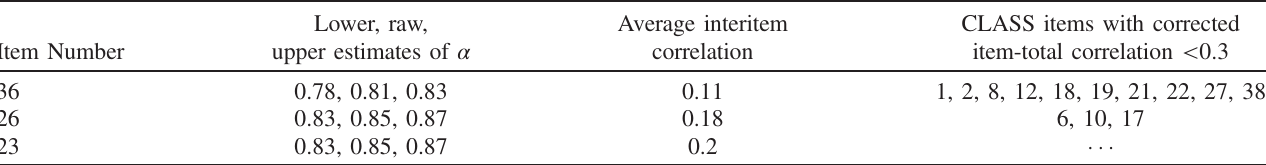
TABLE V. Item removal iterations informed by descriptive